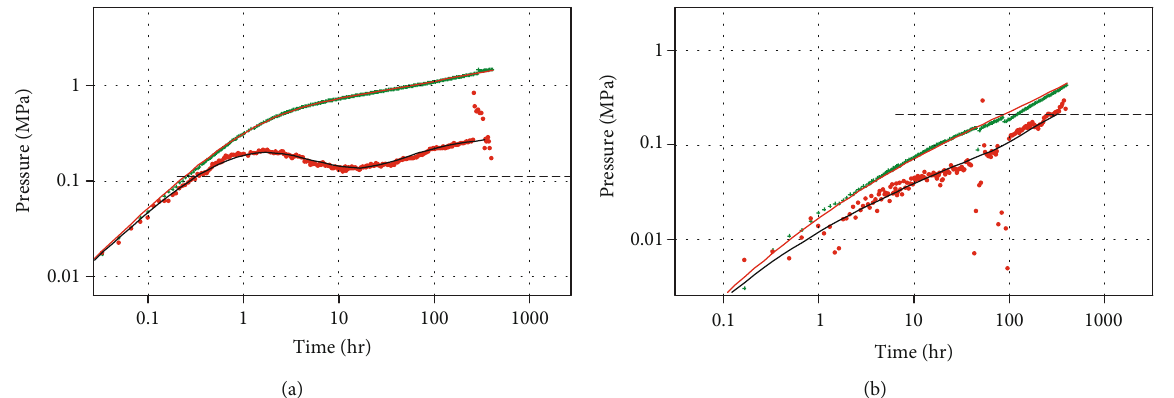
Figure 3: Matching results of BHP responses of water injection well L34-30 in (a) Mar, 2014, and (b) Jul, 2015. Table 1: Production data of this block.